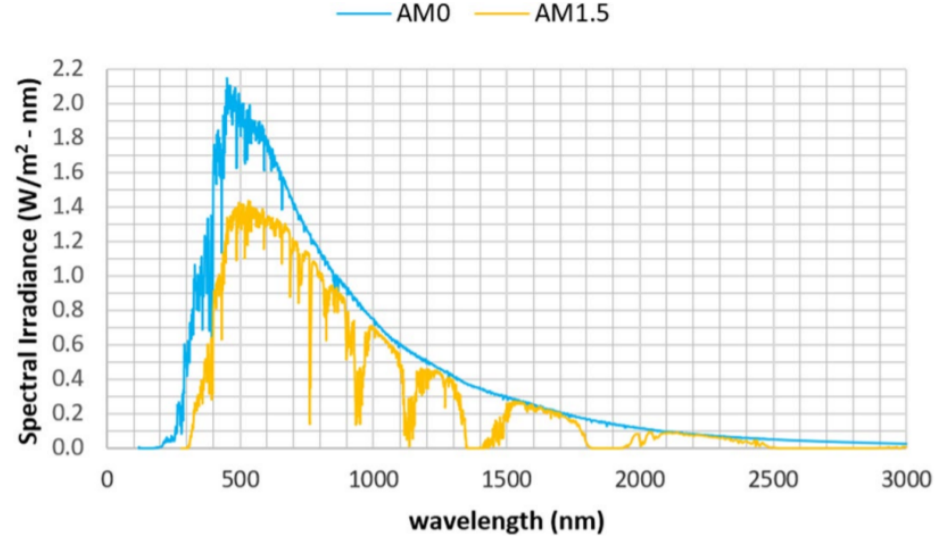
Figure 16. Solar irradiance spectrum: AM0 and AM1.5 spectral